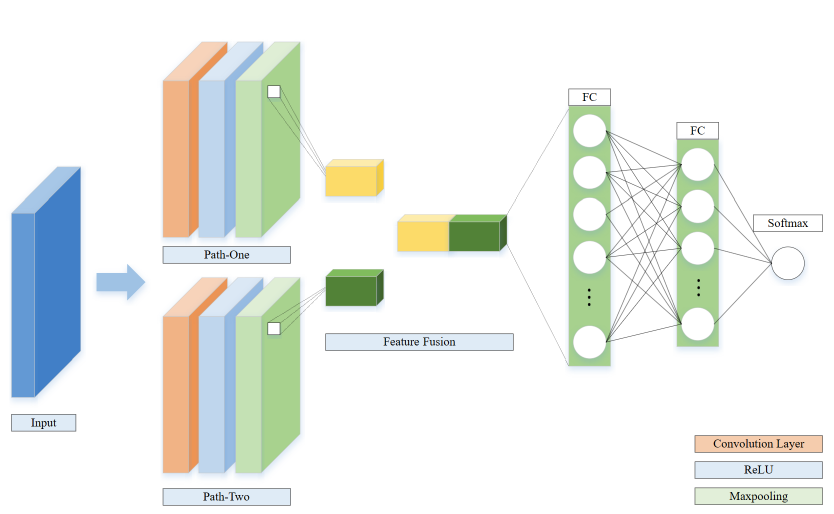
Figure 3. Two-path convolution neural network signal-to-noise ratio evaluation